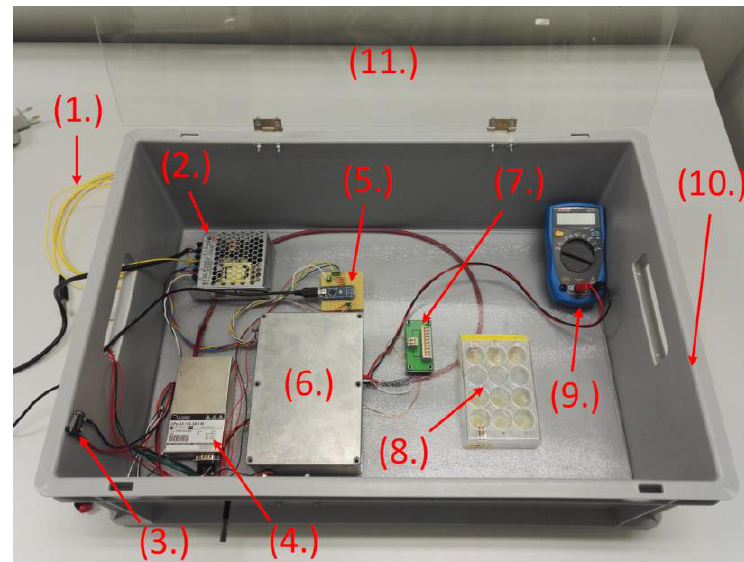
Figure 4. Experimental setup for electroporation experiments: (1) Grounding line, (2) Power supply, (3)